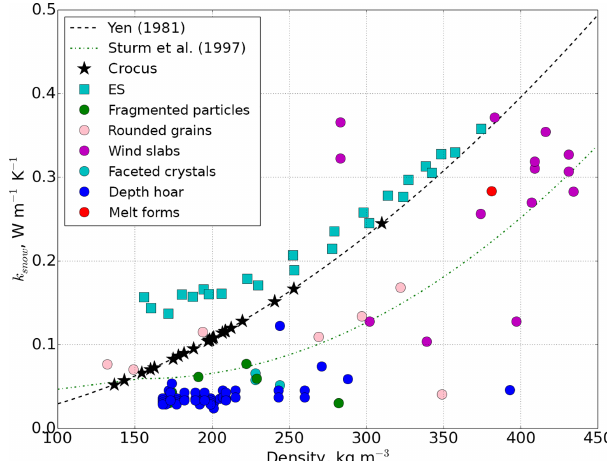
Figure 4. Vertical profiles of snow thermal conductivities measured on 14 May 2014 (a) and 12 May 2015 (b) , and simulated on 14 May 2014 and 6 May 2015.